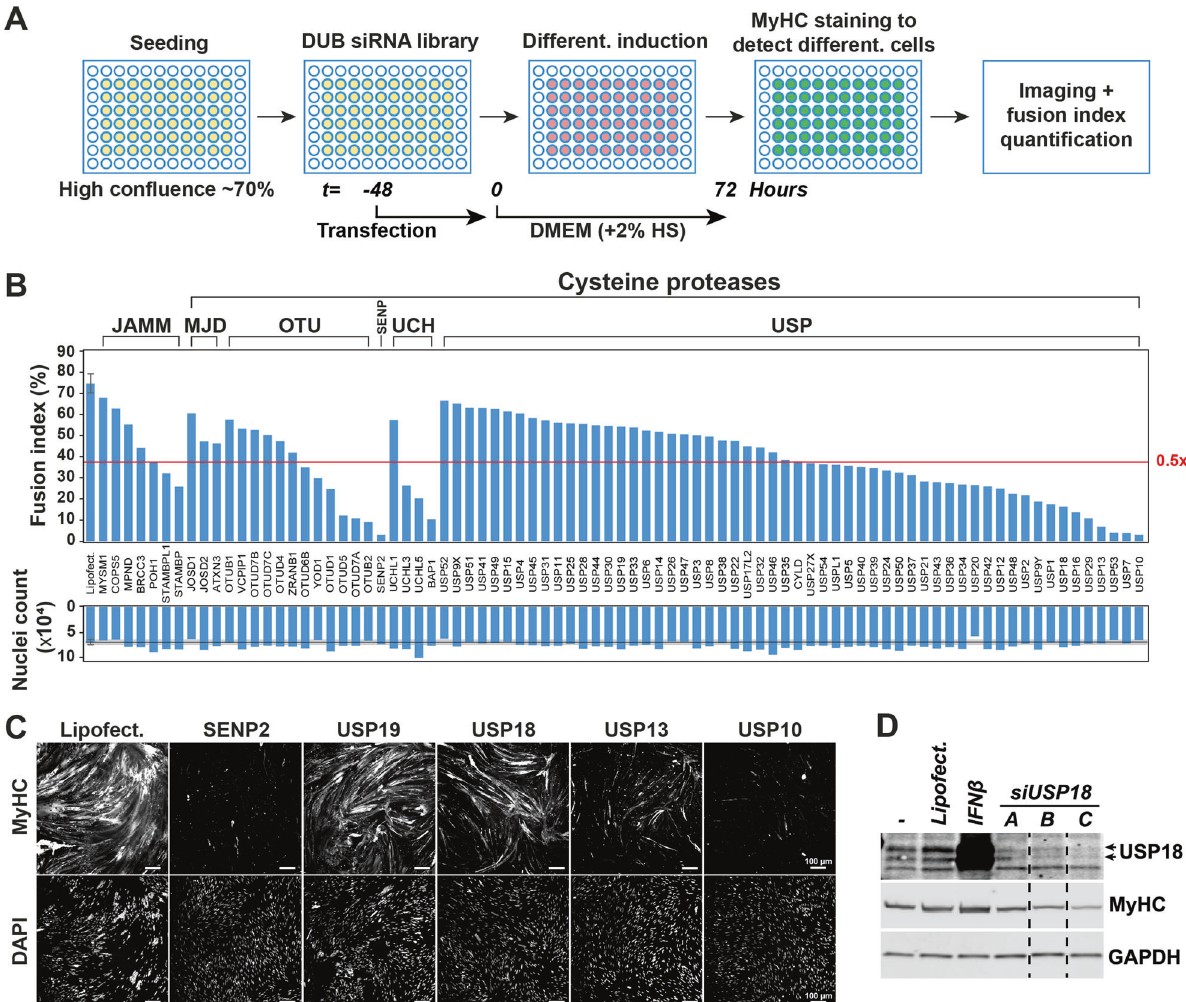
Fig. 1 siRNA DUB screen in human muscle cells under differentiation condition. A A scheme of the screen assay. B Bar charts show fusion index and nuclei count of the respective DUB siRNA transfections. Red line depicts a 37.5% fusion index cut-off, which is half the fusion index of untreated control cells. C Representative images show the MyHC and DAPI fl uorescent staining for several DUB siRNAs transfections. Scale bar is 100 μ m. D Western blot shows USP18 expression in 72 h differentiated cell cultures transfected with three different siRNAs to USP18. Cell cultures treated with Lipofectamine or untreated ( − ) are controls for the knockdown. IFN β treated cultures were used as positive control for USP18 protein expression. MyHC marks muscle cell differentiation and GAPDH is a loading